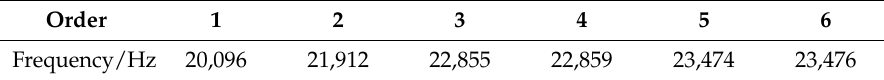
Table 2. Resonant frequencies of the power-superimposed vibrator at the six lowest orders. Order 1 2